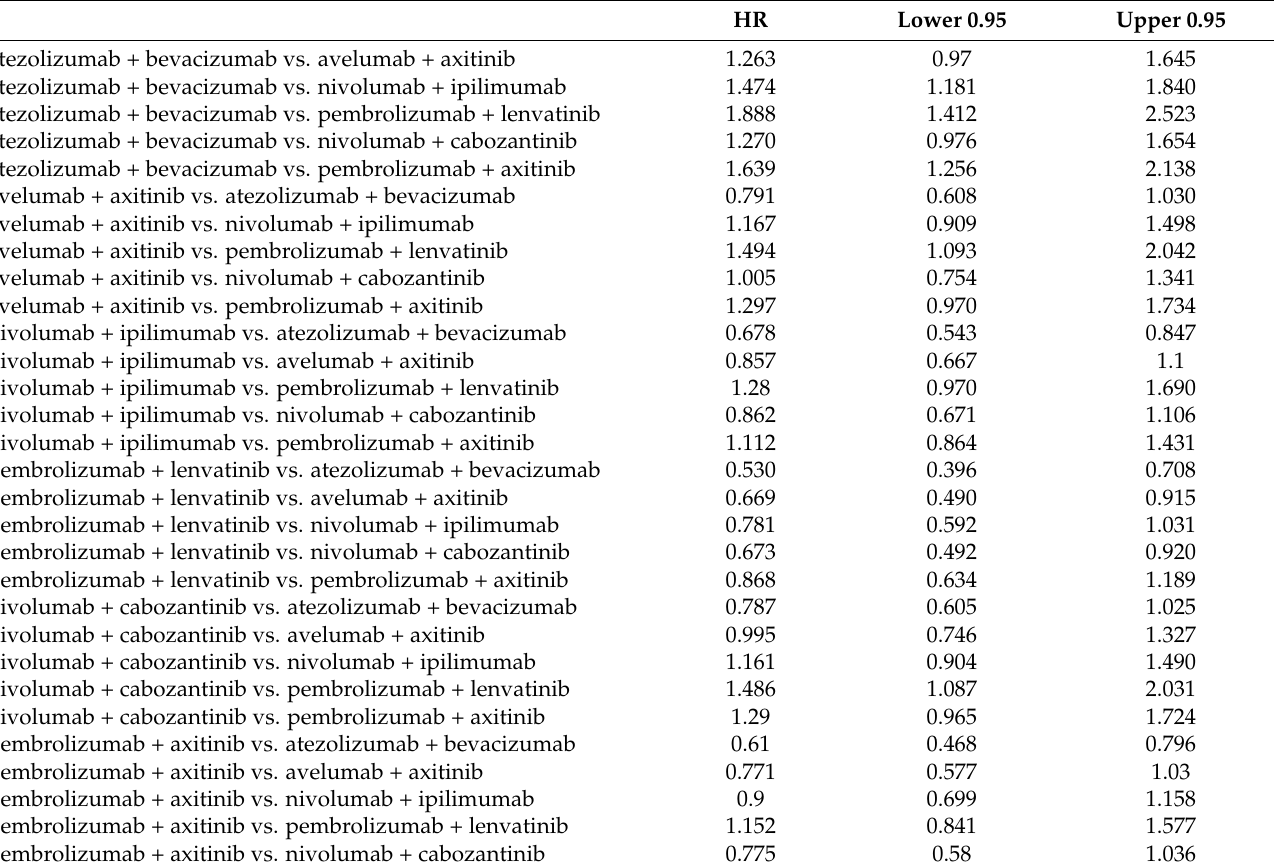
Table 3. Results of statistical analysis of indirect treatment comparison of OS between combina- tion regimens. HR Lower 0.95 Upper